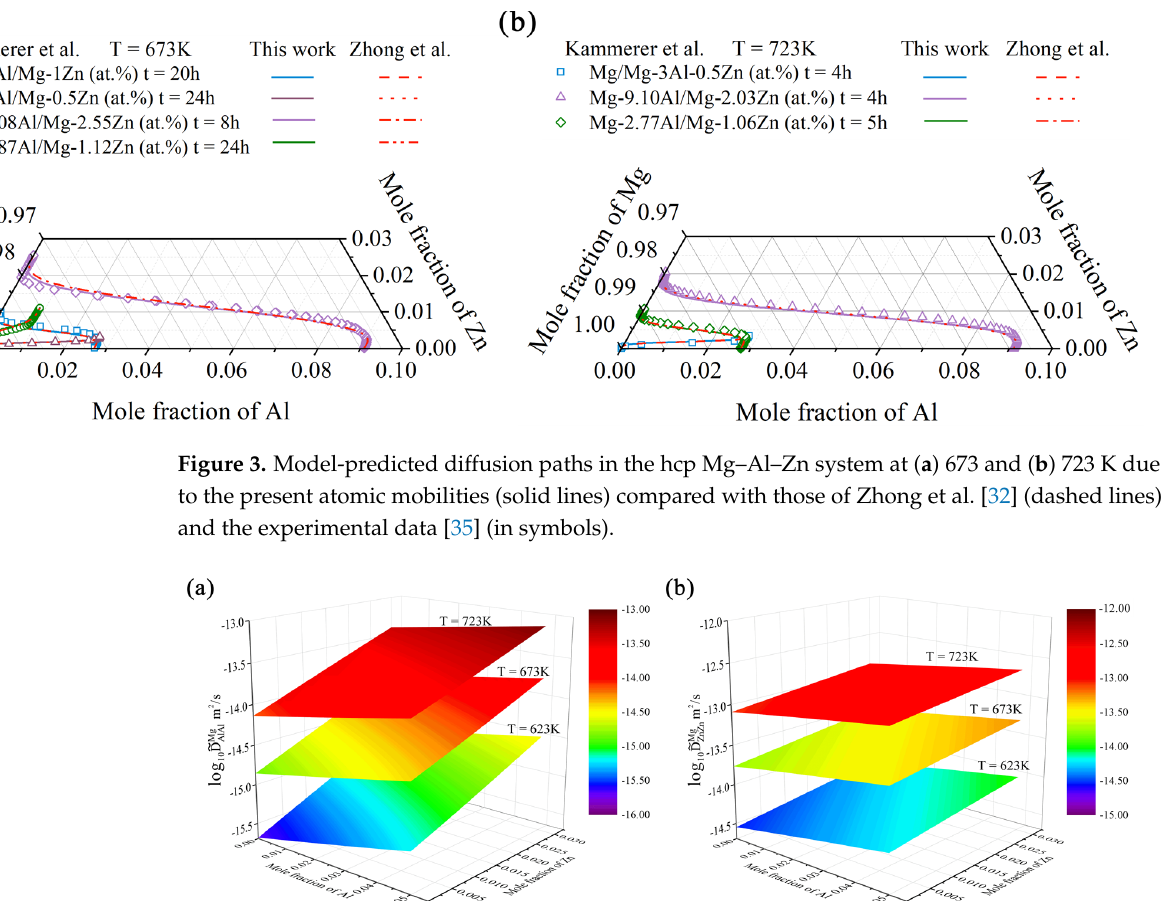
, ( b ) (cid:101) D Mg , ZnZn AlAl